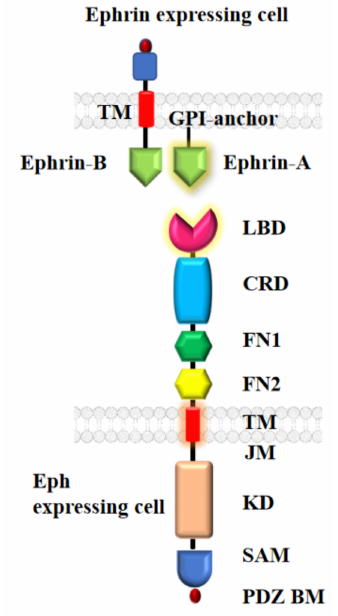
Figure 1. Structural overview of Eph-ephrin complex. An Eph receptor has three distinct regions: Extracellular region consisting of ligand binding domain (LBD), cysteine-rich domain (CRD) and two fibronectin-III like domains (FN1 and FN2); Transmembrane domain (TMD); and Intracellular region consisting of juxta membrane region (JM), kinase domain (KD), sterile alpha motif (SAM) and a PDZ binding motif (PDZ BM). Both ephrinA (GPI-anchored) and ephrinB (transmembrane) ligands interact with the LBD of the Eph